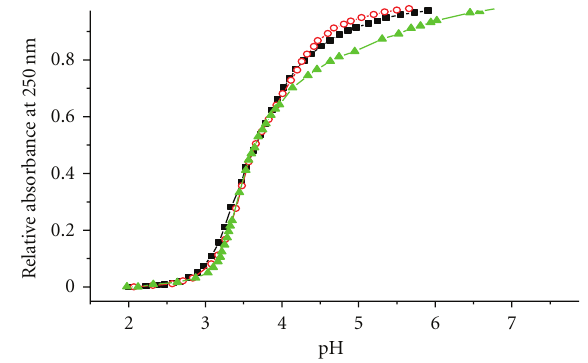
Figure 3: UV absorbance at 250 nm of pH titration of Cd 2+ - reconstituted hGIF ( solid squares ), the (cid:2) 33-35 mutant ( open circles ), and the β (MT3)- β (MT3) mutant ( solid triangles ). All proteins are dissolved in 10 mM Tris-HCl, 100 mM KCl, and pH